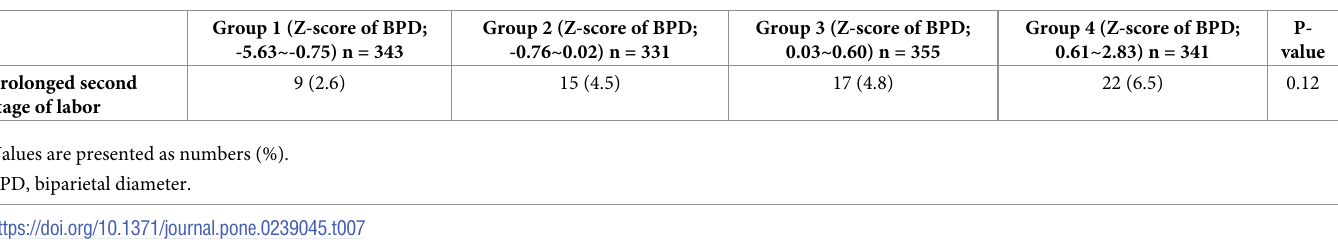
Table 7. Prevalence of prolonged second stage of labor according to Z-score of fetal biparietal diameter quartiles measured within 7 days before delivery in multipa- rous